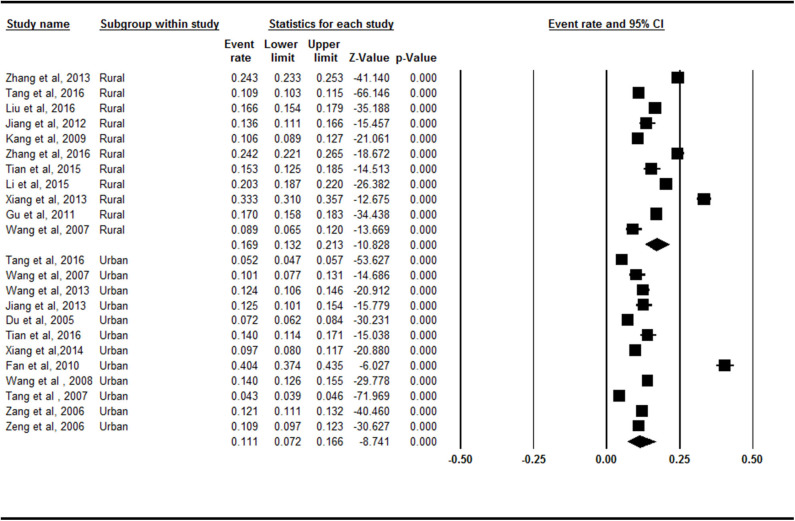
Forest plot of the prevalence rates of symptomatic knee osteoarthritis by region. CI, confidence interval. Eleven and 12 studies, respectively, investigated the prevalence of symptomatic knee osteoarthritis in rural and urban. The rural (16.9%, 95% CI = 13.2–21.3%) had a higher prevalence of symptomatic knee osteoarthritis than the urban (11.1%, 95% CI = 7.2–16.6) in the subgroup analysis.